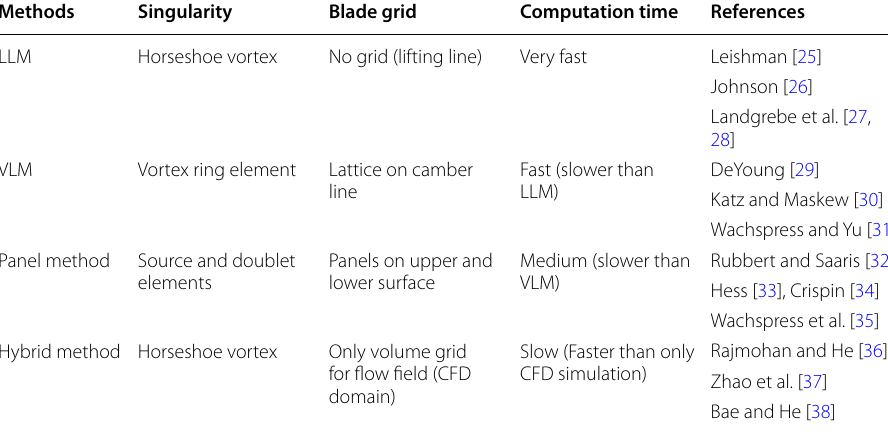
Table 1 Overview of blade models for rotor simulation